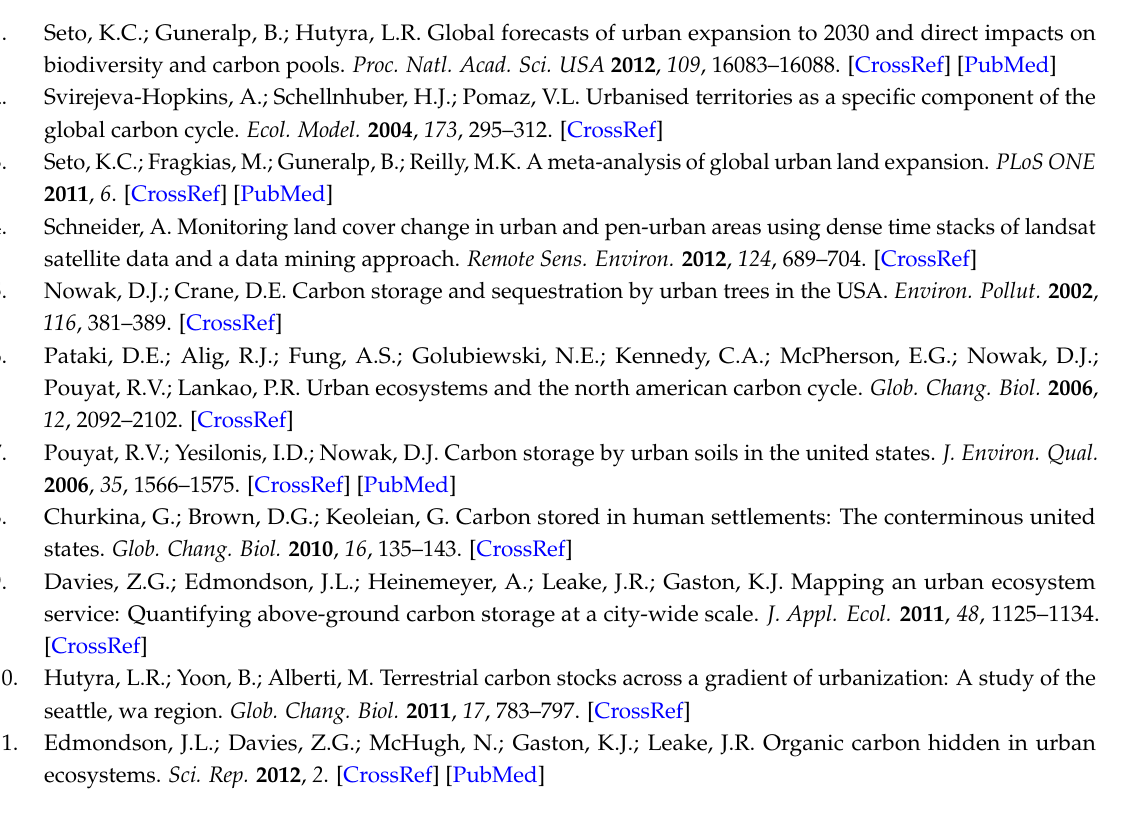
Figure S1: Comparison of green vegetation spectrum that before the atmospheric correction in 1990 (a) and 2010 (c) and after the atmospheric correction in 1990 (b), and 2010 (d), Figure S2: Four fractional images—soil, low-albedo object, high-albedo object and green vegetation that generated by two group of endmemebers with same spatial distribution, which were selected from the same Landsat 5 TM image acquired in 1990 before the atmospheric correction (a–d) and after the atmospheric correction (e–h), Figure S3: Four fractional images—soil, low-albedo object, high-albedo object and green vegetation that generated by two group of endmemebers with same spatial distribution, which were selected from the same Landsat 5 TM image acquired in 2010 before the atmospheric correction (a–d) and after the atmospheric correction (e–h), Figure S4: Histograms of Four land-cover component—soil, low-albedo object, high-albedo object and green vegetation of 1600 randomly selected pixels from the fractional maps that generated from the image before the atmospheric correction (a–d) and after the atmospheric correction (e–h) in the year of 1990, Figure S5: Histograms of four land-cover component—soil, low-albedo object, high-albedo object and green vegetation of 1600 randomly selected pixels from the fractional maps that generated from the image before atmospheric correction (a–d) and after atmospheric correction (e–h) in the year of 2010, Table S1: Paired t -test analysis of 1600 pixels randomly selected from the atmospheric corrected and not corrected images in 1990 and